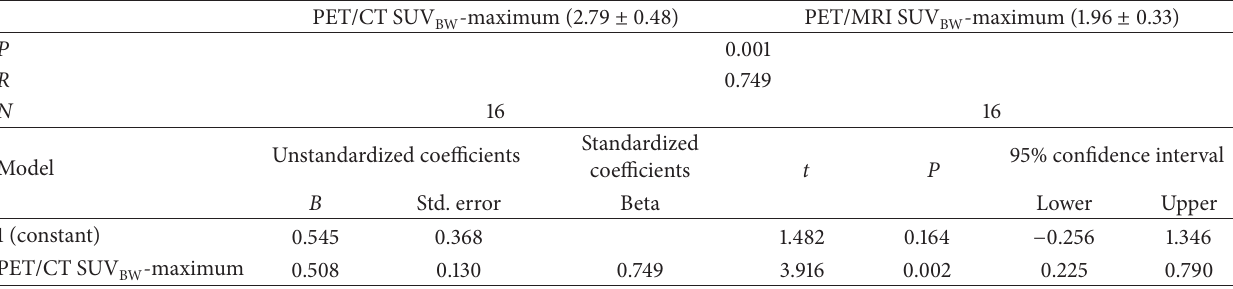
-maximum and PET/MRI SUV BW